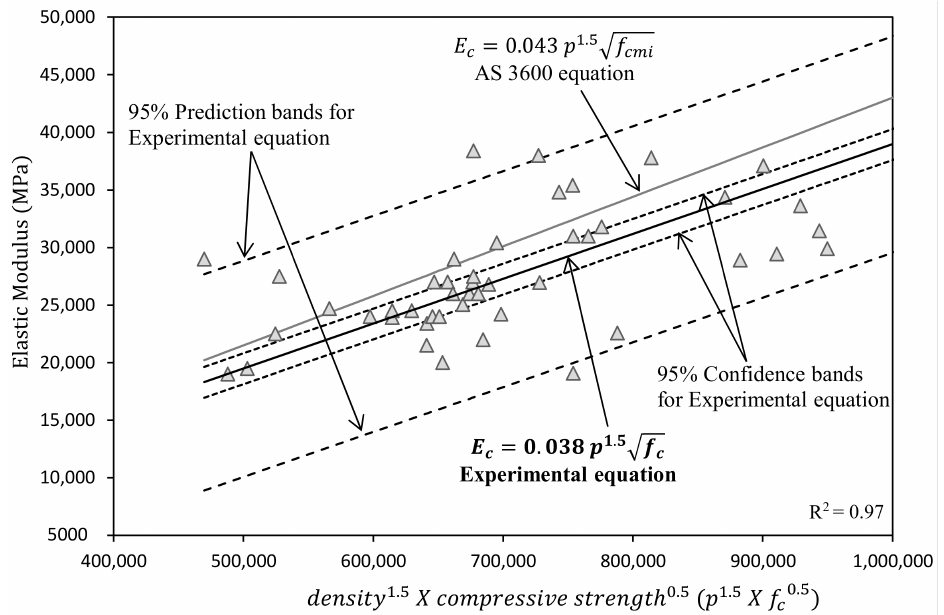
Figure 6. Correlation between compressive strength vs. elastic